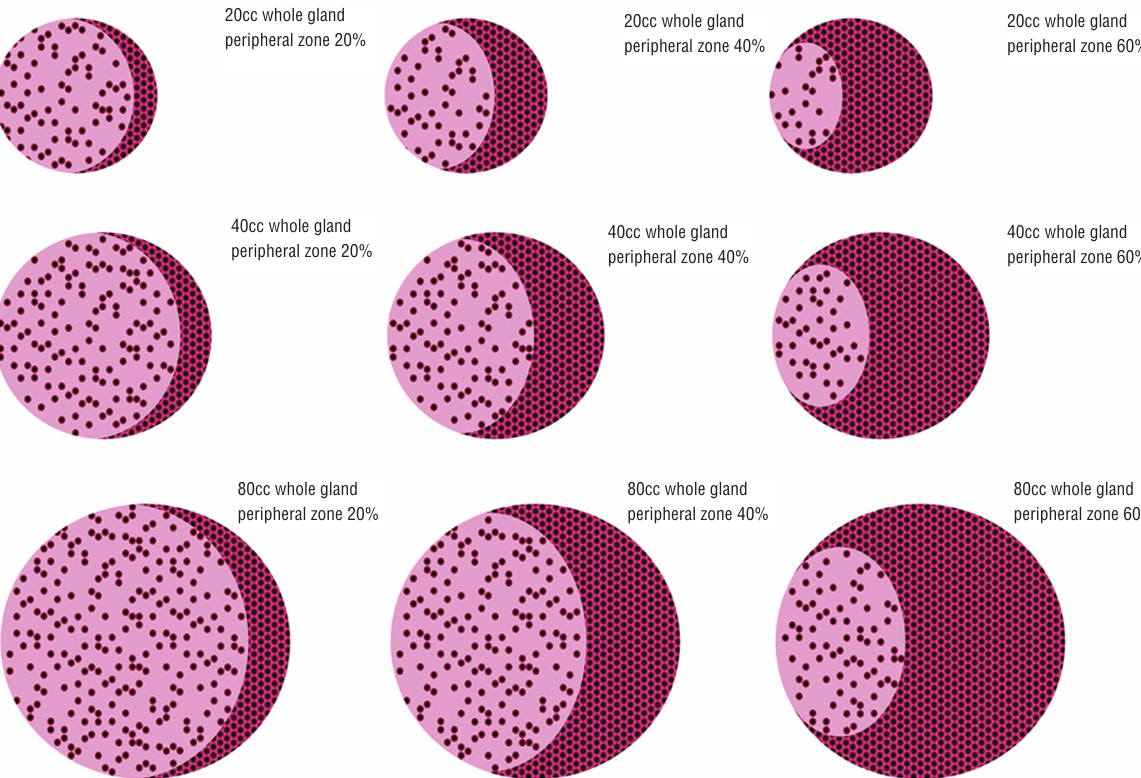
Whole gland volume 20cc top row; Whole gland volume 40cc middle row; Whole gland volume 80cc bottom row